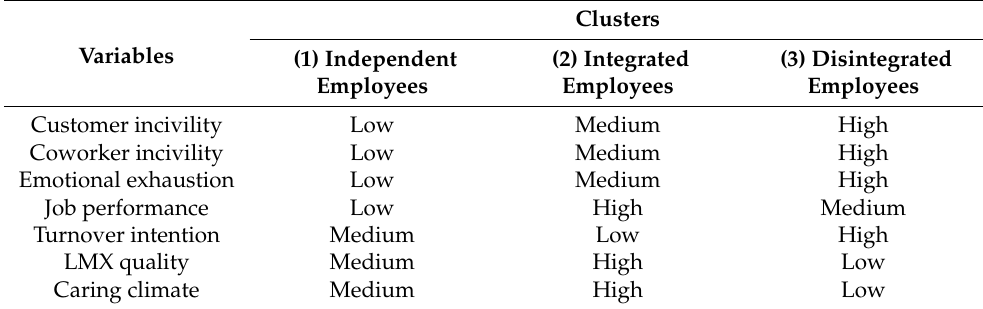
Figure 1. Final cluster solution for frontline service employees’ profiles (three-cluster solution). Table 3. Initial comparison of three